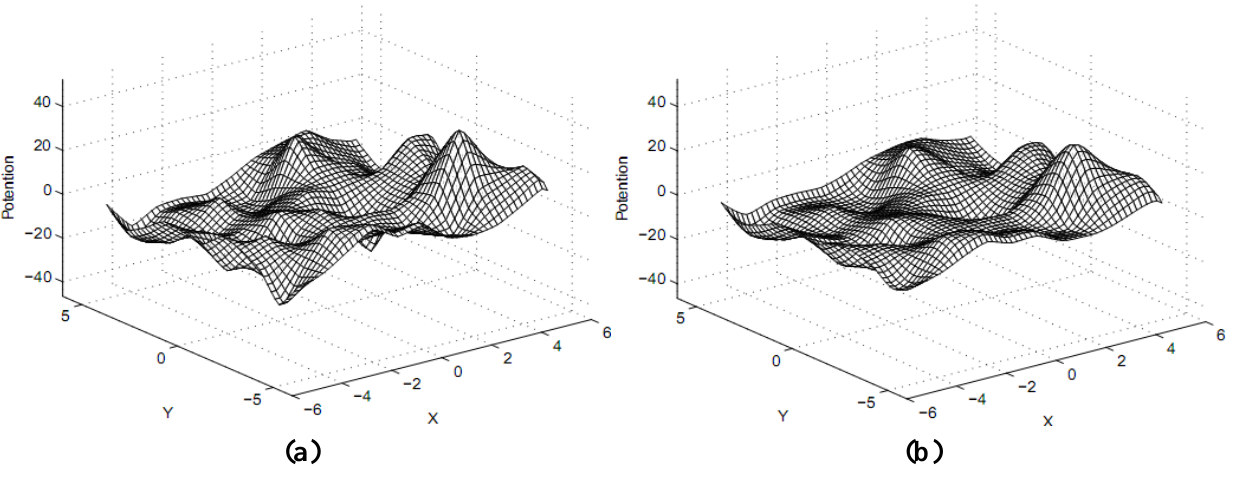
Figure 2. Evolution of potential field under the controlling of variable